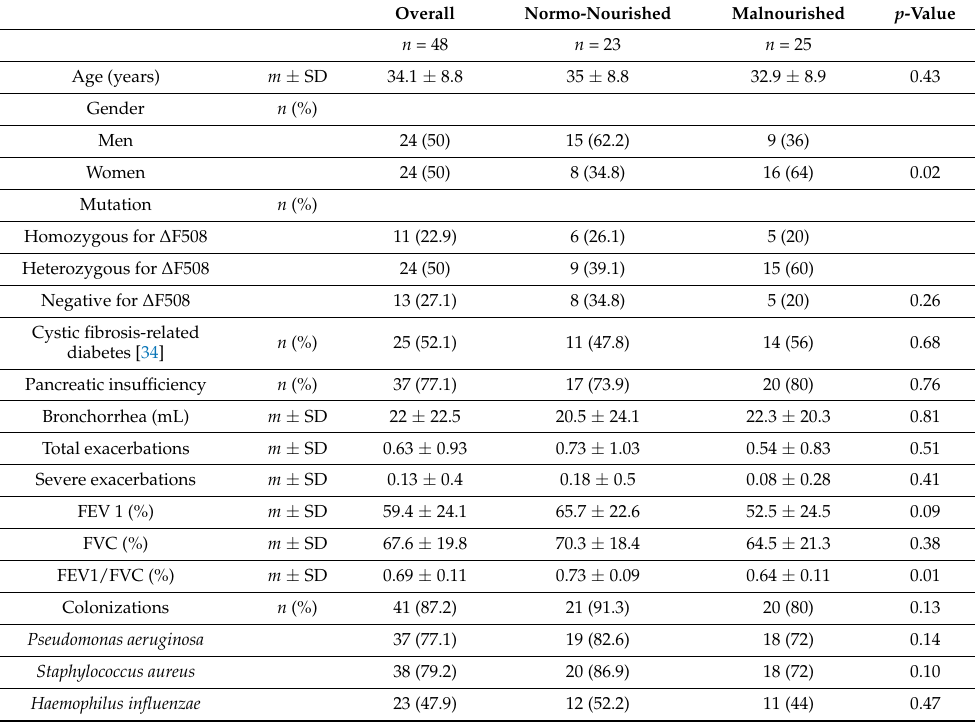
Table 1. General characteristics and respiratory status, adjusted by nutritional